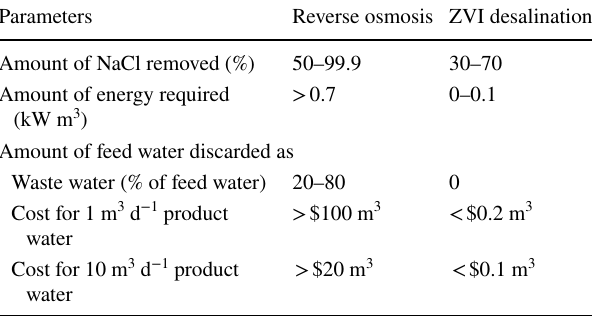
Table 2 Comparison of conventional desalination with ZVI desalina- tion. Source Antia 2017, 2018a, b, c) Parameters Reverse osmosis ZVI